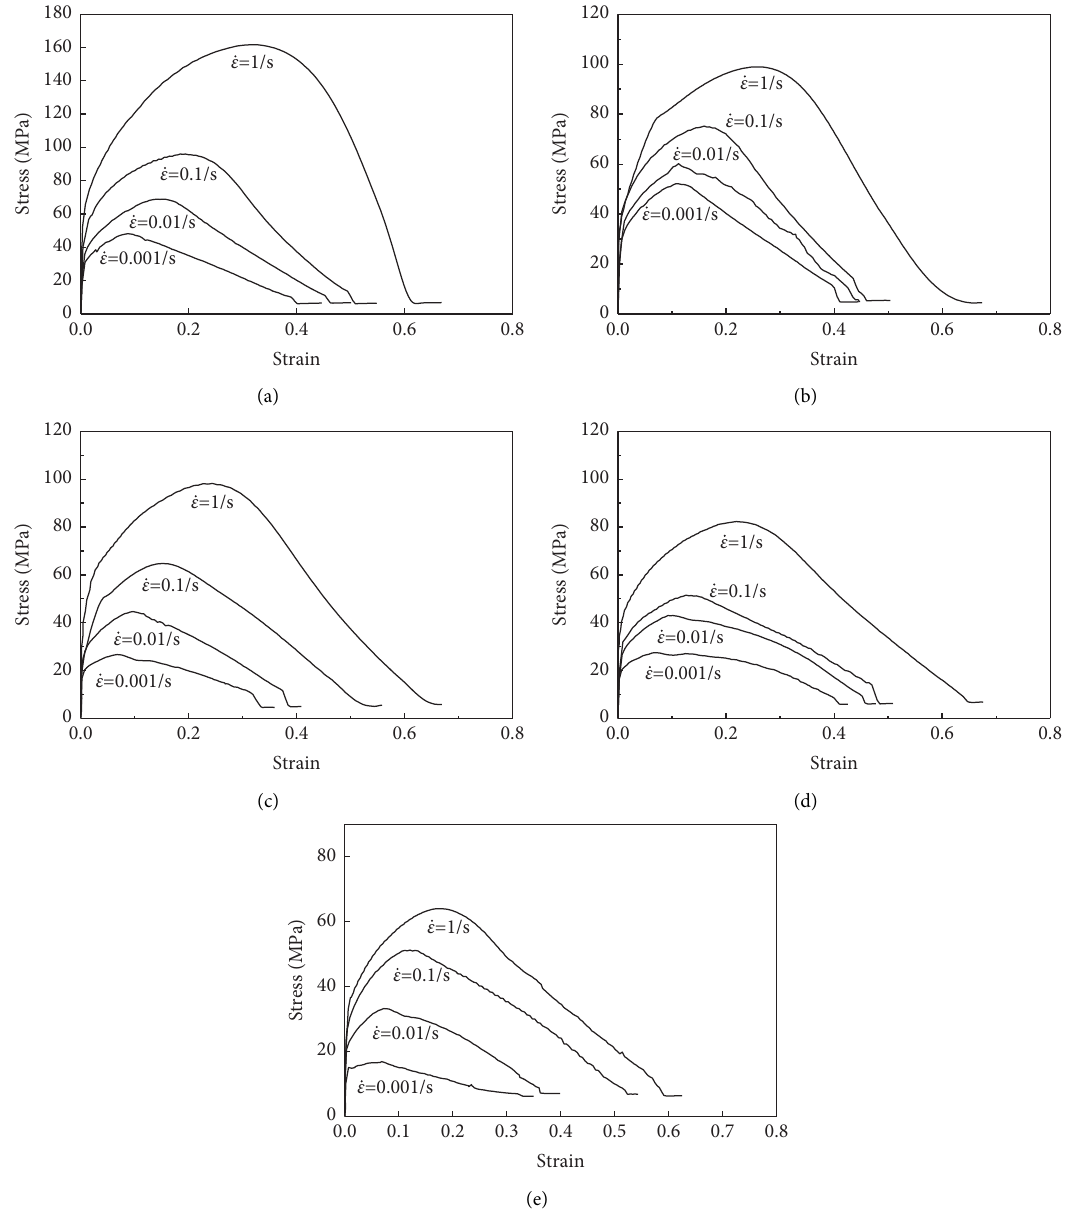
Figure 3: Relationships between true stress-strain for as-cast 42CrMo steel at different temperatures: (a) 1223 K. (b) 1273 K. (c) 1373 K. (d) 1423 K. (e) 1473